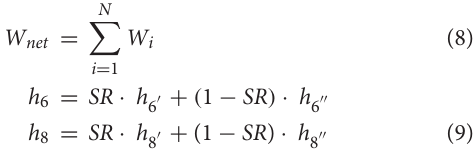
Supplementary Table 1 . The analysis was performed at steady-state conditions, neglecting pressure and heat loss in all system components. We have performed the golden section method (Lindfield et al., 2012) as a direct optimization process. The objective function is iteratively calculated for various values of the independent